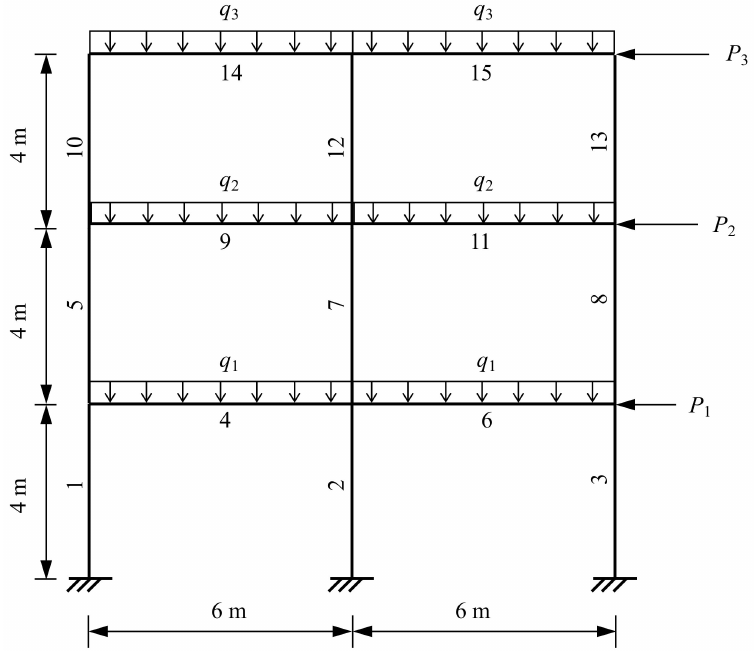
Figure 3. Skeleton of the considered precast concrete frame: geometry, applied loads and numbering of structural